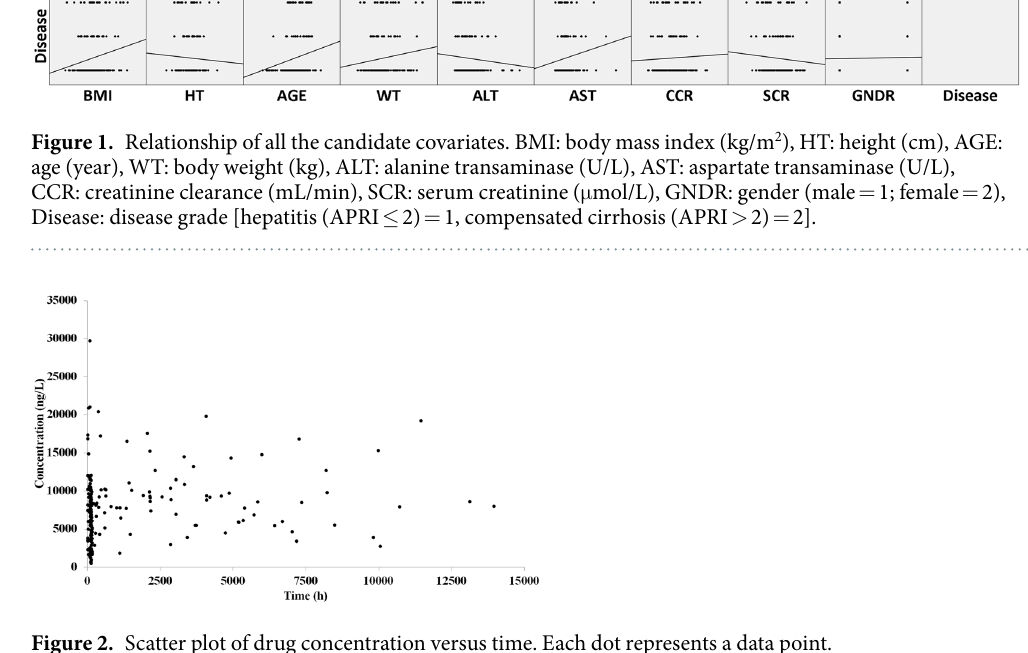
In equation 4, the 0.094 (L/h) is the typical value of the CL, and 91.39 (mL/min) is the mean value of CCR. The 0.31 is the estimated coefficient which represents the relationship between the CCR and CL. In equation 5, 15.6 (L) means the V for an individual with the mean value of BMI (23.41 kg/m 2 ), and 1.81 is the exponent between them (V and BMI). 0.028 (1/h) was the population typical value of K a (equation 6), and no covariate had an effect